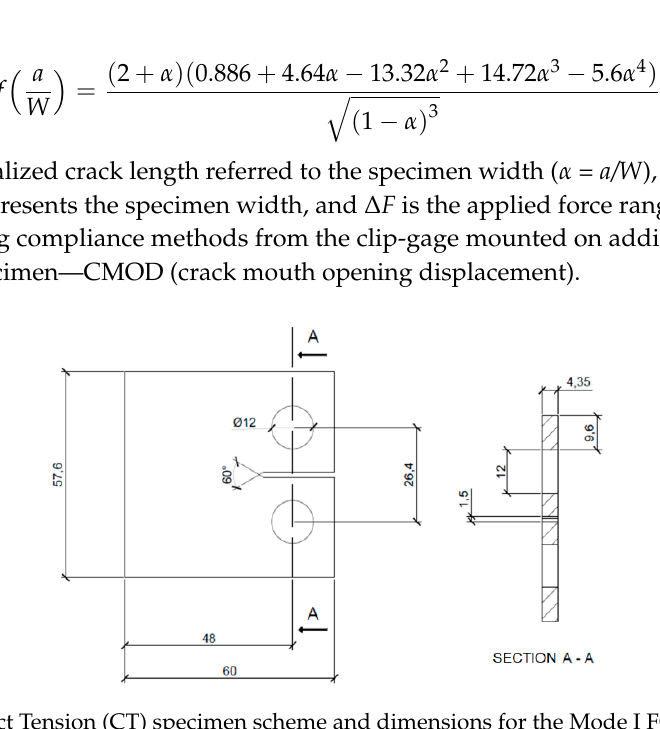
Table 1. Chemical composition (in % by weight) of the tested materials.